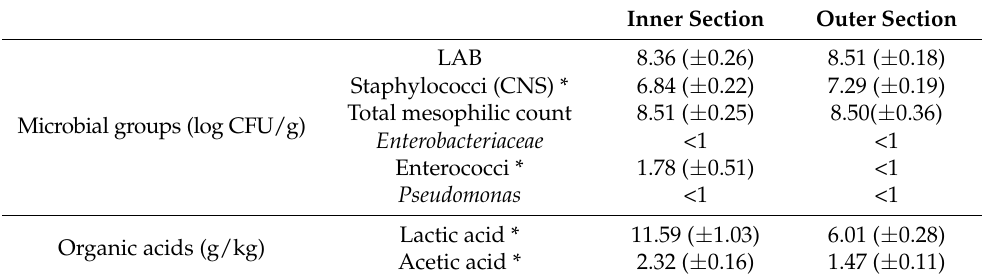
Table 1. Microbiological analyses (log CFU/g) and organic acids concentration (g/kg) of the ripened sausages in the inner and in the outer section. Results are the mean of three independent repetitions. For each microbial group and organic acid significant differences between samples according to Mann-Whitney test are indicated by the presence of an asterisk.